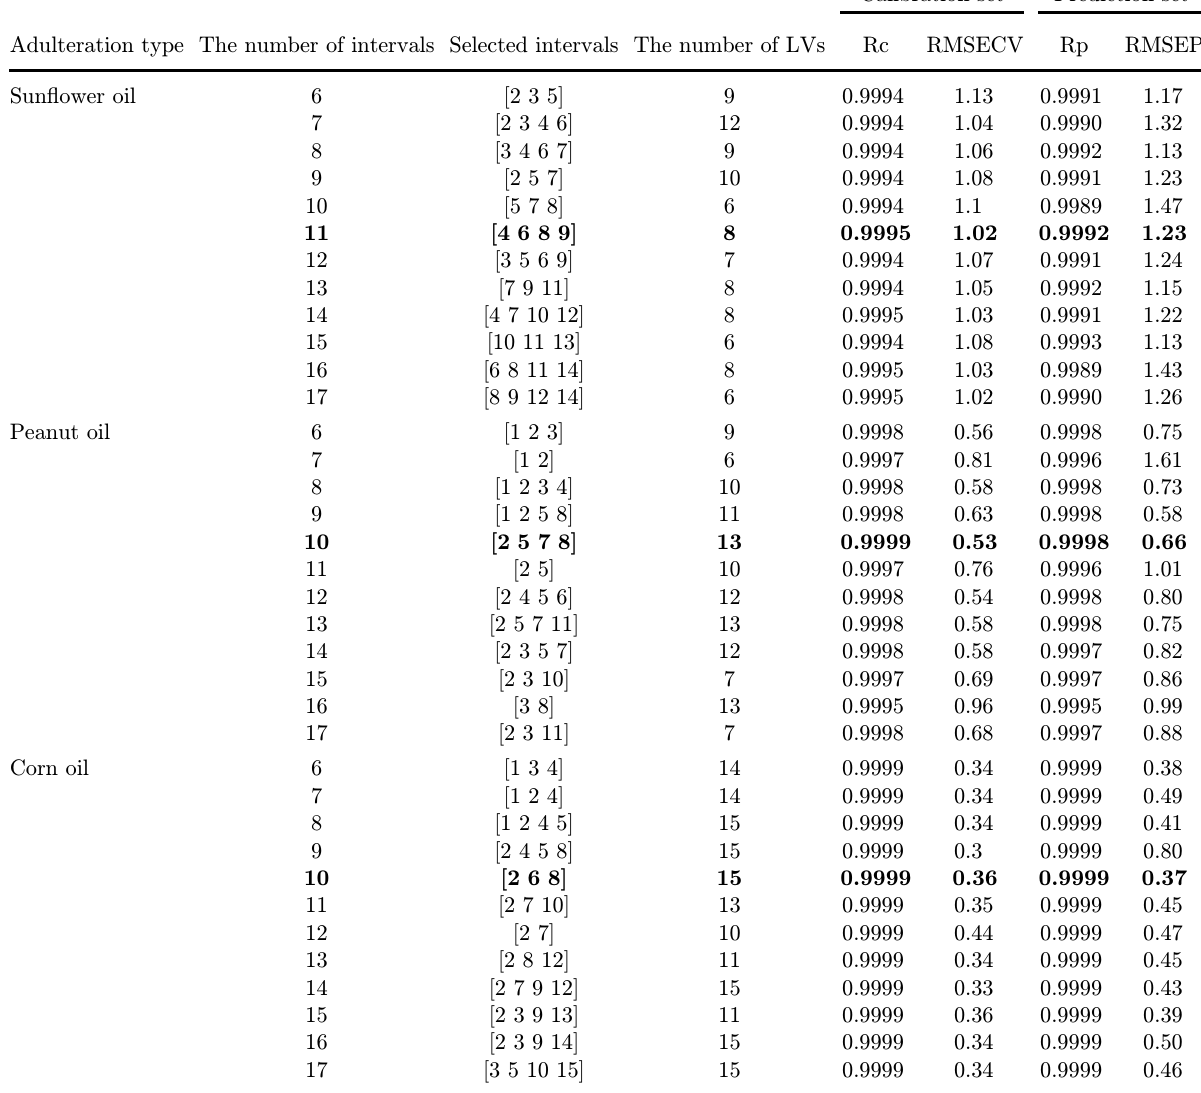
Calibration set Prediction